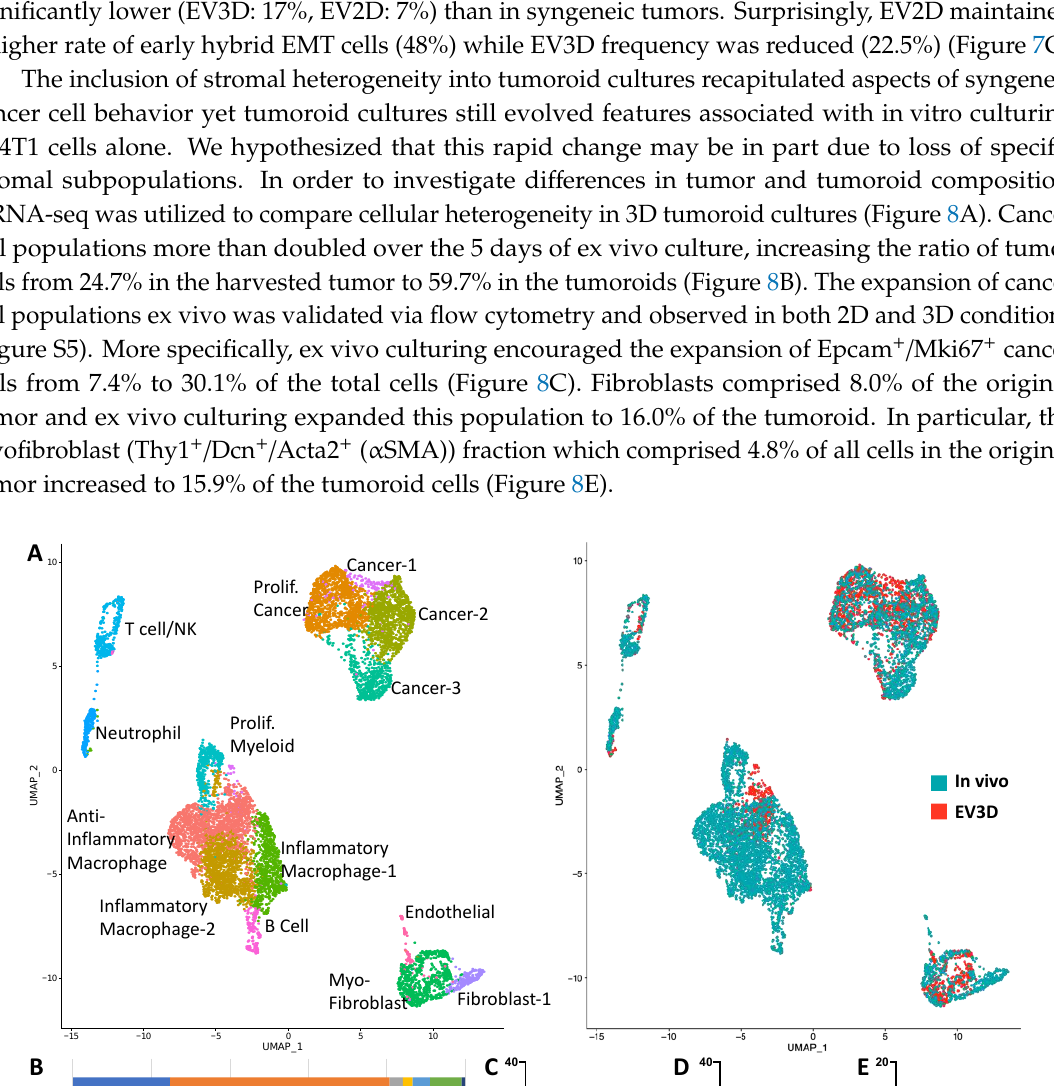
ECM organization DEGs of SBM vs. 2D across culturing conditions. ( E ) Violin plot of magnitude of differential expression of interferon signaling DEGs of SBM vs. 2D across culturing conditions. ( F ) Flow cytometric analysis of 4T1 cells undergoing EMT following 5 days of ex vivo culturing. ( G ) Abundance of hybrid EMT states following ex vivo culturing. Tumoroid conditions n = 6 from three